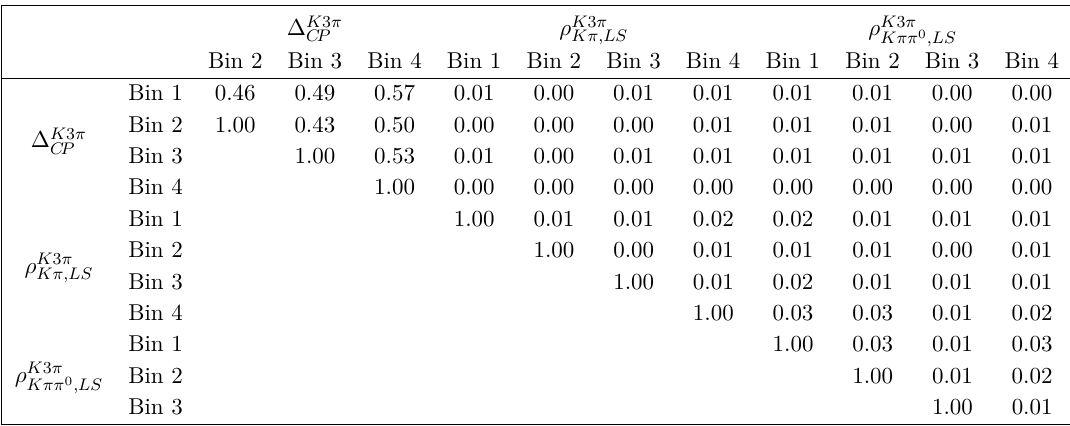
Table 16 . Correlation matrix for the observables in the binned analysis. The off-diagonal elements involving the binned ρ K 3 π observables, which are not shown, are all 0.01 or LS